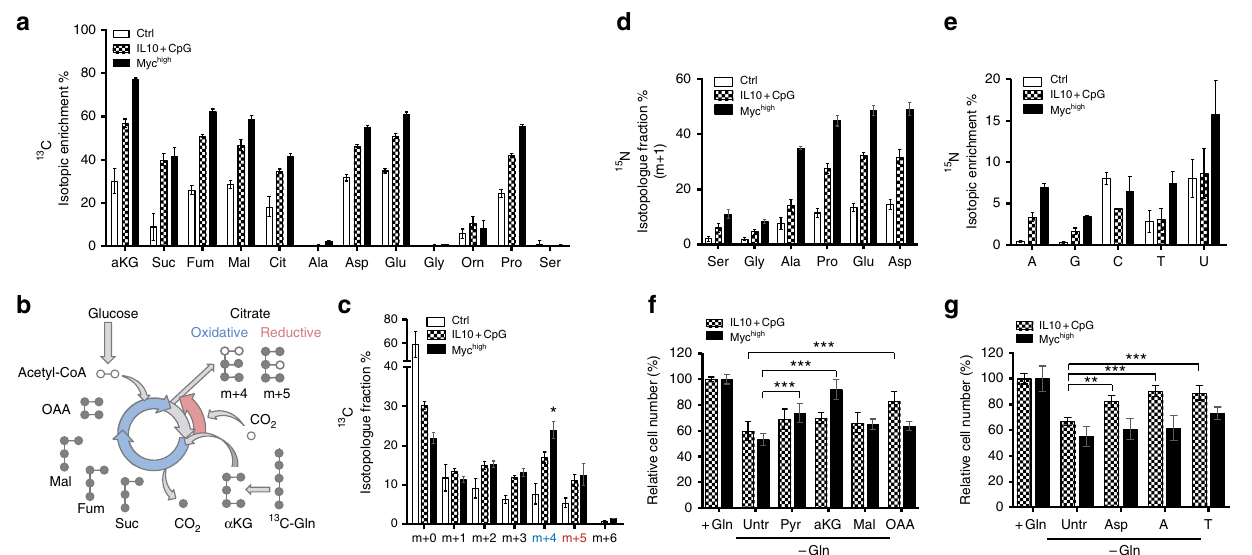
Fig. 2 Proliferation of IL10 + CpG-stimulated and MYC-overexpressing cells is dependent on different glutamine-derived metabolites. a Mean isotopic enrichment of metabolites in unstimulated and IL10 + CpG-stimulated P493-6 MYC low , as well as unstimulated P493-6 MYC high cells treated with 13 C 5 - glutamine within the text only 13C5-Gln is used?. b Scheme of oxidative decarboxylation (blue) and reductive carboxylation (red). Both can be distinguished by isotopic labelling in mass spectrometry. c Isotopic fractions of citrate in IL10 + CpG-stimulated P493-6 MYC low and P493-6 MYC high cells. Mass spectra were analysed according to the different masses of citrate. Data on 1- 13 C-glutamine within the main text 1-13C-Gln is used ? labeling are summarized in Supplementary Fig. 5. Fractions of d m + 1 15 N isotopologue in selected amino acids and e 15 N-enriched nucleobases in unstimulated and IL10 + CpG-stimulated P493-6 MYC low , as well as P493-6 MYC high cells. f , g Relative cell counts of IL10 + CpG-stimulated P493-6 MYC low and P493-6 MYC high cells grown in Gln-deprived and metabolite-treated media. Cells were treated with either f TCA metabolites (Pyr = pyruvate, α -KG = dimethyl 2- oxoglutarate, Mal = diethyl malate, OAA = oxaloacetate) or g aspartate (Asp) and nucleobases (A = adenine, T = thymine) for 24 h. For all plots, error bars represent mean ± SD of three independent experiments and results from Bonferroni post hoc tests on a one-way ANOVA results are given (* p < 0.05, ** p < 0.01, *** p <